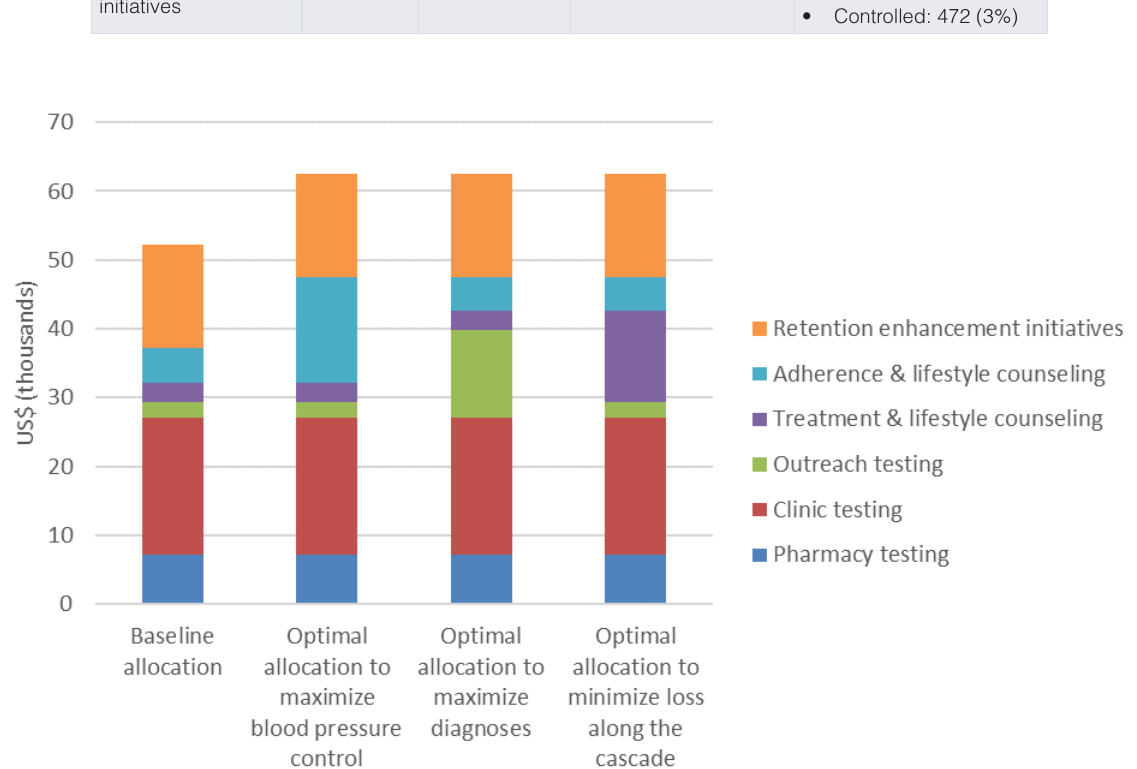
Figure 8. Optimal allocations for achieving difference targets related to the illustrative hypertension